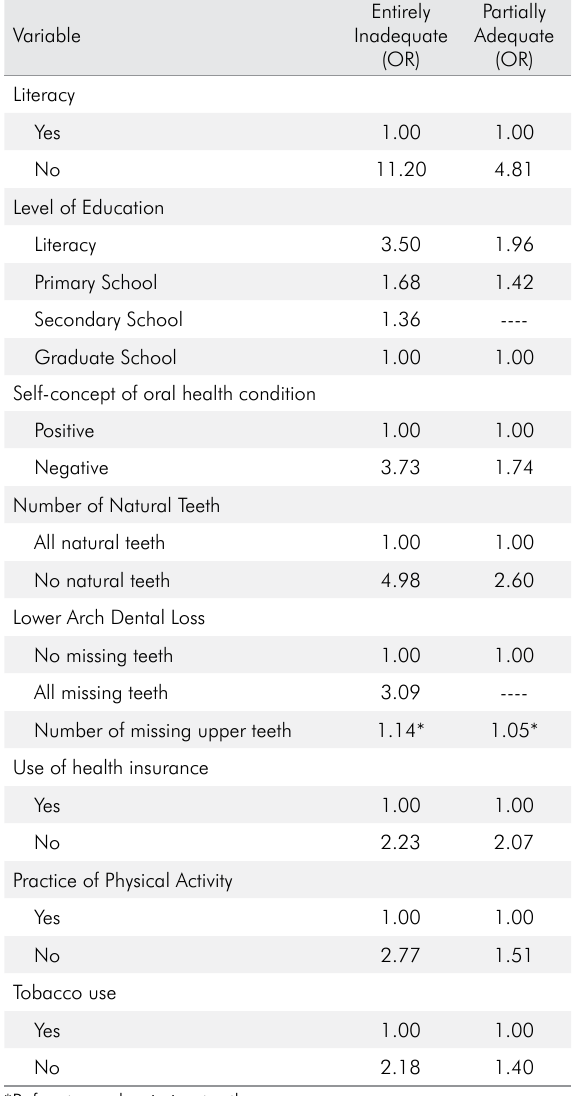
Table 4. Reasons for entirely inadequate and partially adequate oral self-care according to independent